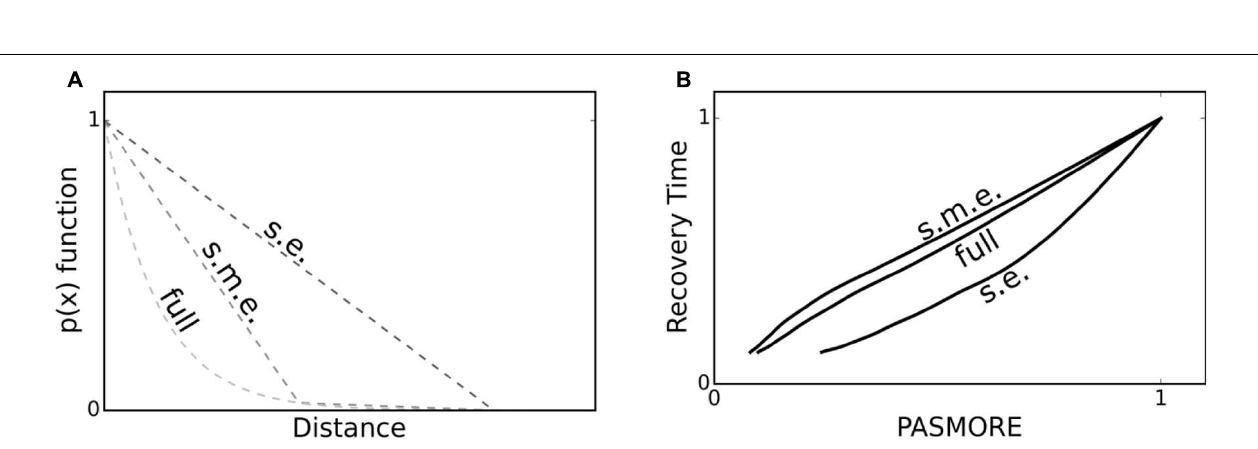
FIGURE 4 | Recovery time – recovery length and recovery time – PASMORE relationships for two different perturbation profiles: step-change (A,B) and exponential (C,D). For a step-change perturbation, recovery length correctly correlates with recovery time (A) , however, it is unable to correctly correlate when the perturbation profile is exponential (C) . PASMORE correctly correlates to recovery time regardless of the perturbation profile (B,D) .